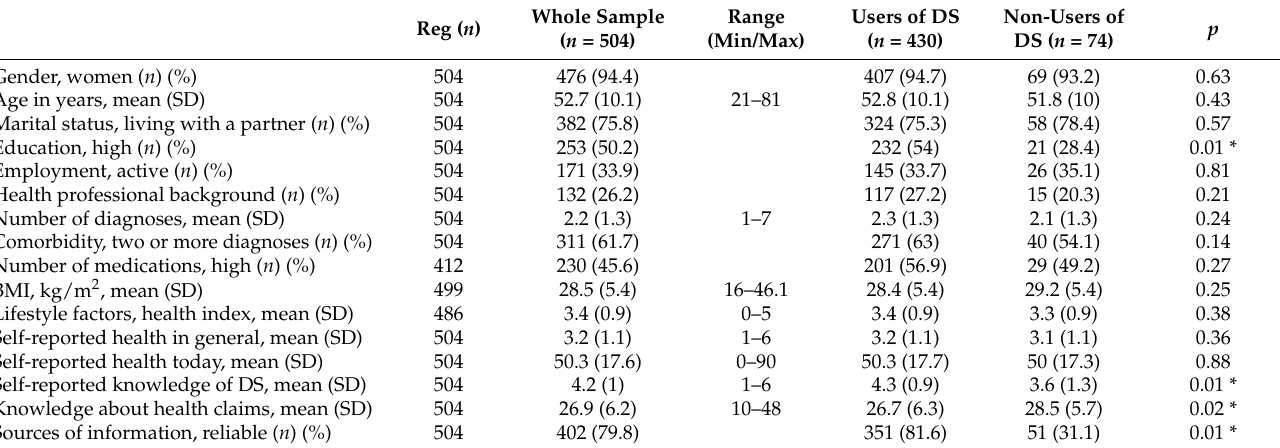
Table 1. Characteristics of the whole sample and the users and non-users of